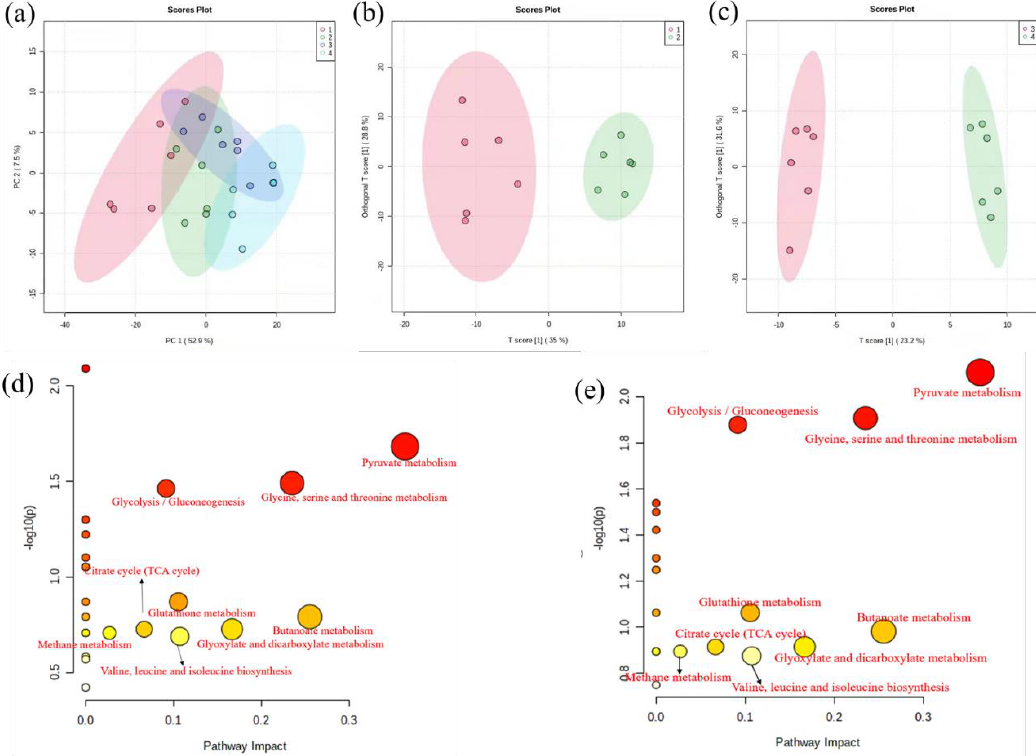
Figure 3. ( a ) shows the PCA models for 24 samples; numbers 1,2 represent the control group and copper exposure in the logarithmic phase, and numbers 3,4 represent the control group and copper exposure in the stationary growth phase. ( b , c ) separation of control (red) and copper exposure (green) samples in logarithmic phase and stationary growth phase using OPLS-DA, respectively. ( d , e ) metabolites changes mapped to the metabolic pathways exposed to 0.5 mmol/L Cu 2+ of Plano- coccus sp. O5 in the logarithmic and stationary growth